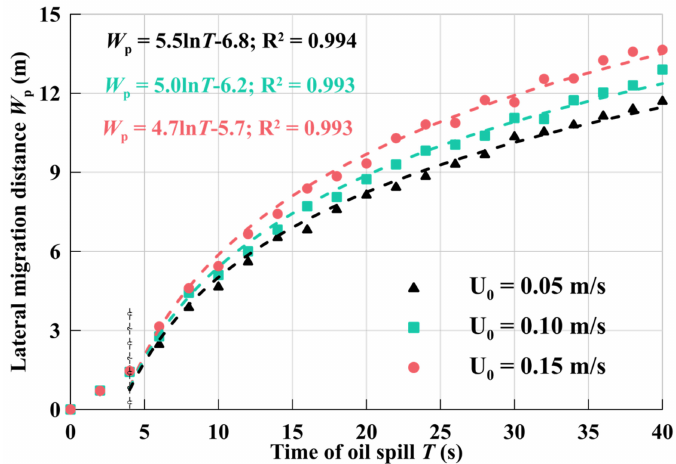
Figure 9. Lateral migration distance of spilled oil for three different maximum ocean current velocities. ( U P = 0.10